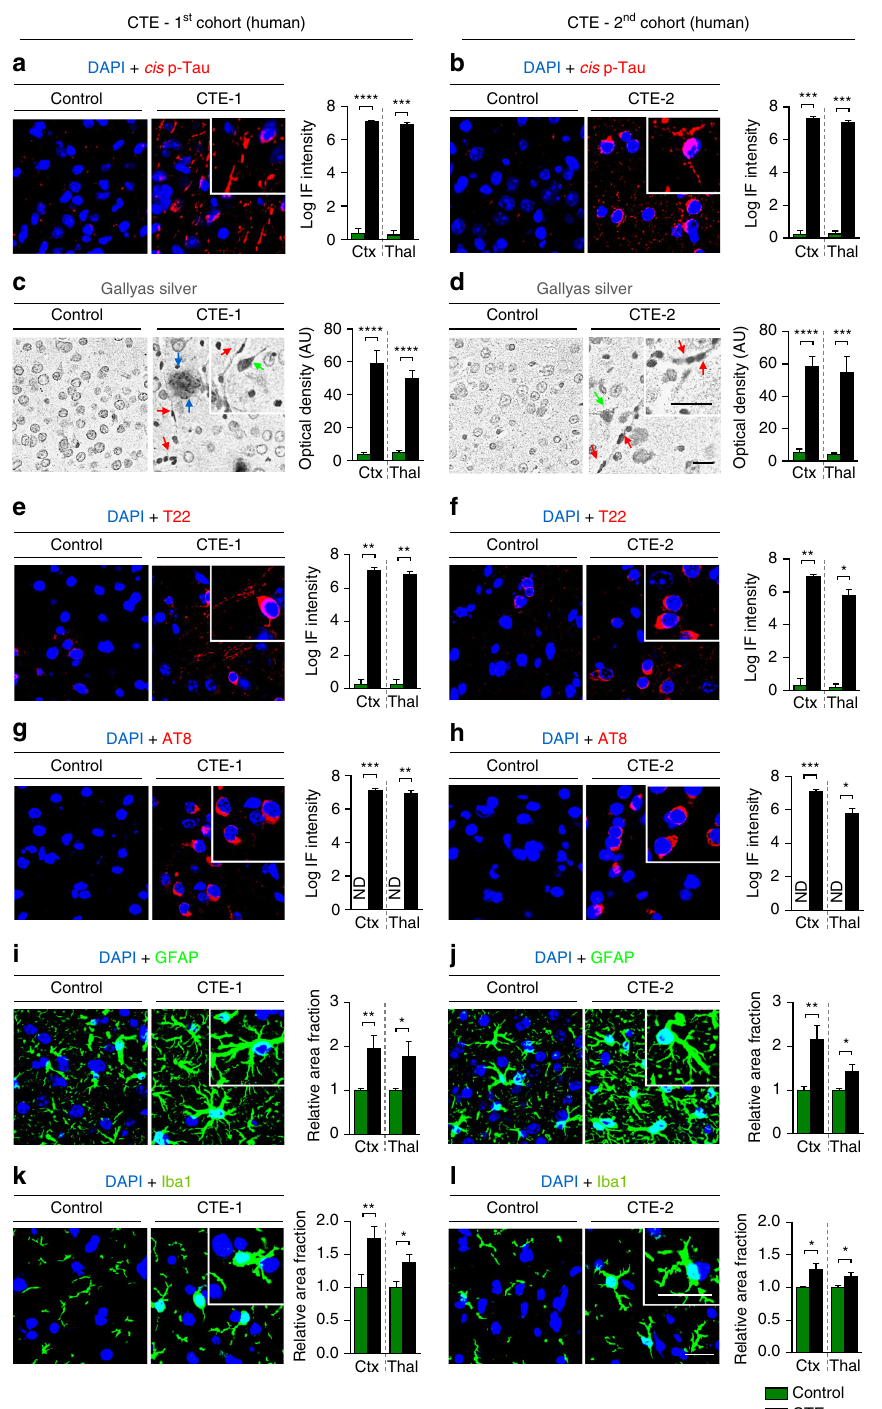
Fig. 3 Cis P-tau is expressed in both the cortex and deep brain regions and correlates with various neuropathological features in CTE patients. CTE brain sections of the cortex and thalamus from eight collision sport athletes under ages of 75 from two independent sources and age-matched controls (Supplementary Table 3) were subjected to immunostaining or Gallyas silver staining, followed by confocal microscopy and light microscopy, respectively, to detect cis P-tau and various CTE pathologies. Cis P-tau staining a , b was correlated with the presence of axonal pathology, as detected by Gallyas silver staining c , d , tau oligomerization (T22) e , f , early tangles (AT8) g , h , astrogliosis (GFAP) i , j and microgliosis (Iba1) k , l in two different brain regions. Inset images are the high magni fi cation image of selected area denoted by the white. Of note, there was not detectable signals when secondary antibodies were used alone (data not shown). Scale bar, 40 μ m. Different types of pathologies in CTE brains revealed by Gallyas silver staining: senile plaque (blue arrow); neuro fi brillary tangles (green arrow); axonal bulb (red arrow). Ctx, parasagittal cortex; Thal, thalamus; ND, not detectable; NS, not signi fi cant. Images were quanti fi ed and results are shown as means ± S.E.M. and p -values calculated using unpaired two-tailed parametric Student ’ s t -test. * p < 0.05, ** p < 0.01, *** p < 0.001, **** p <